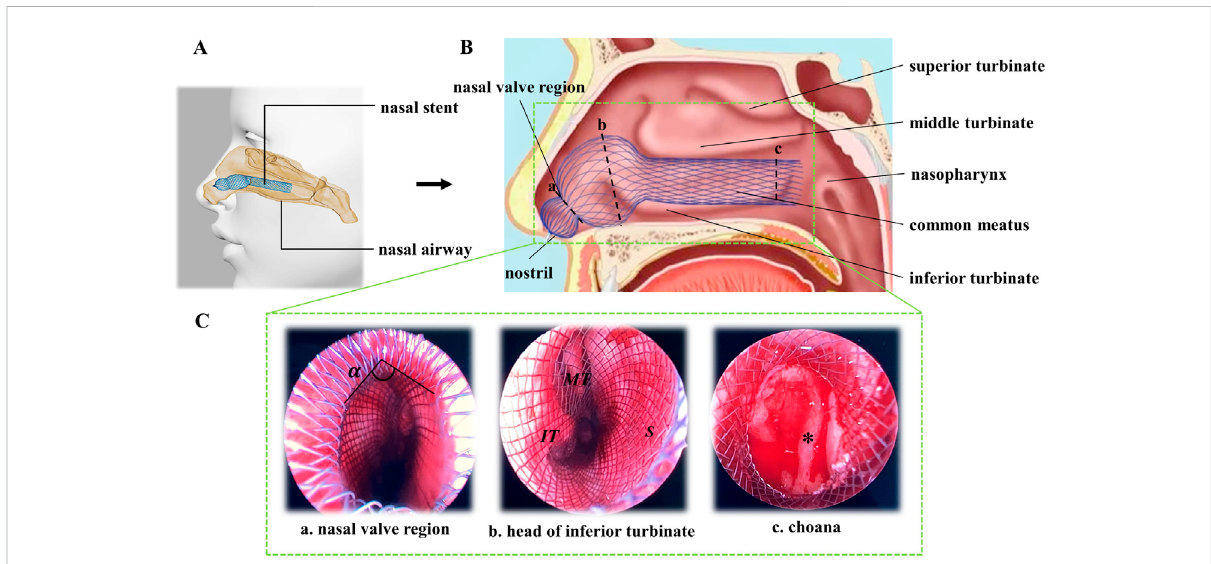
FIGURE 1 Scheme of nasal stent working in nasal cavity. (A) Digital model of nasal airway with nasal stent. (B) Sagittal view of nasal cavity. (C) Coronal images of nasal endoscope. α , nasal valve angle; MT, middle turbinate; IT, inferior turbinate; ✽ ,